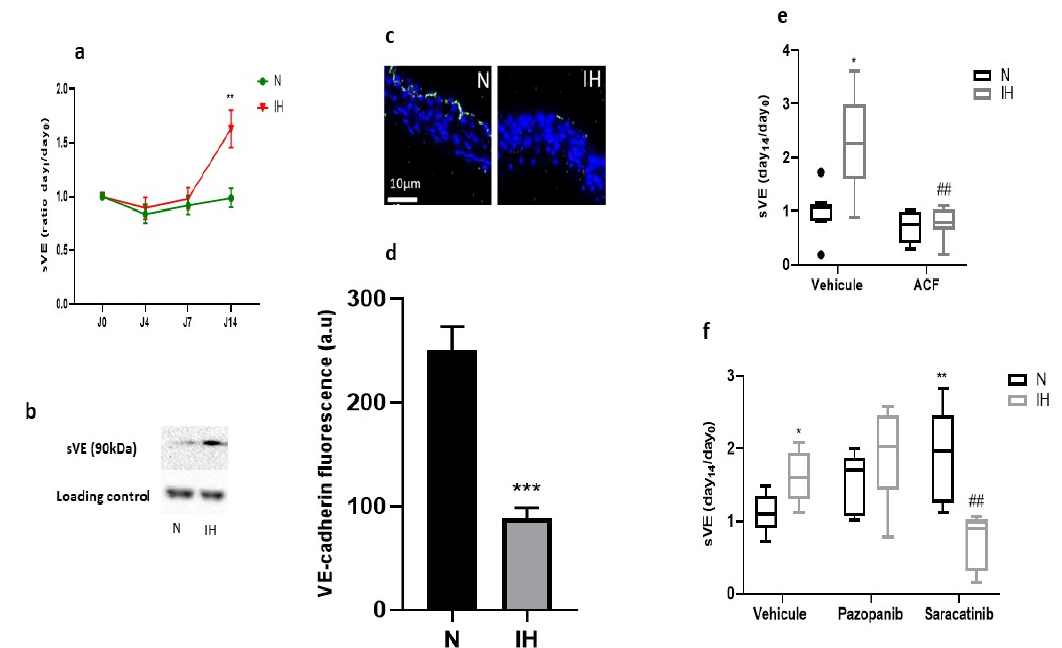
Figure 2. Intermittent hypoxia impairs VE-cadherin integrity in vivo in C57BL/6J mice, which is prevented by inhibitors of VE-cadherin cleavage. ( a ) IH increased sVE level in the plasma of C57BL/6J mice treated with vehicle (DMSO) after 14 days of exposure to IH, semi-quantitatively measured by Western blotting (N vs. IH at day 14, ** p < 0.01, Welch t -test, n = 21–22, values are mean ± SEM). ( b ) A representative example of Western blot showing a more intense sVE-band in the plasma of mice exposed to IH compared to those exposed to normoxia for 14 days (the immunoglobulin band is used as a loading control for normalization). ( c ) A representative example showing a more intense VE-cadherin fluorescence on the endothelium in N not in IH. Arrows indicate the VE-cadherin fluorescence in green in the endothelium, and the blue staining corresponds to nuclei stained with DAPI. ( d ) IH reduced VE-cadherin expression in the endothelium of C57BL/6J mice after 14 days of exposure to IH (N vs. IH at day 14, *** p < 0.001, Welch t -test, n = 15–16, values are mean ± SEM). ( e ) Inhibiting HIF-1 (by ACF) prevented the IH-induced elevation of sVE level in the plasma of C57BL/6J mice exposed for 14 days to IH or N (Kruskal-Wallis test, * p < 0.05 vs. N + vehicle, ## p < 0.01 vs. IH + vehicle, n = 6–8, values are median + interquartile range). ( f ) Inhibiting VEGFR tyr-kinases (by pazopanib) or src-kinases (by saracatinib) prevented the IH-induced elevation of sVE level in the plasma of C57BL/6J mice exposed for 14 days to IH or N (Kruskal-Wallis test, * p < 0.05 and ** p < 0.01 vs. N + vehicle, ## p < 0.01 vs. IH + vehicle, n = 5–8, values are median + interquartile range). N: normoxia, IH: intermittent